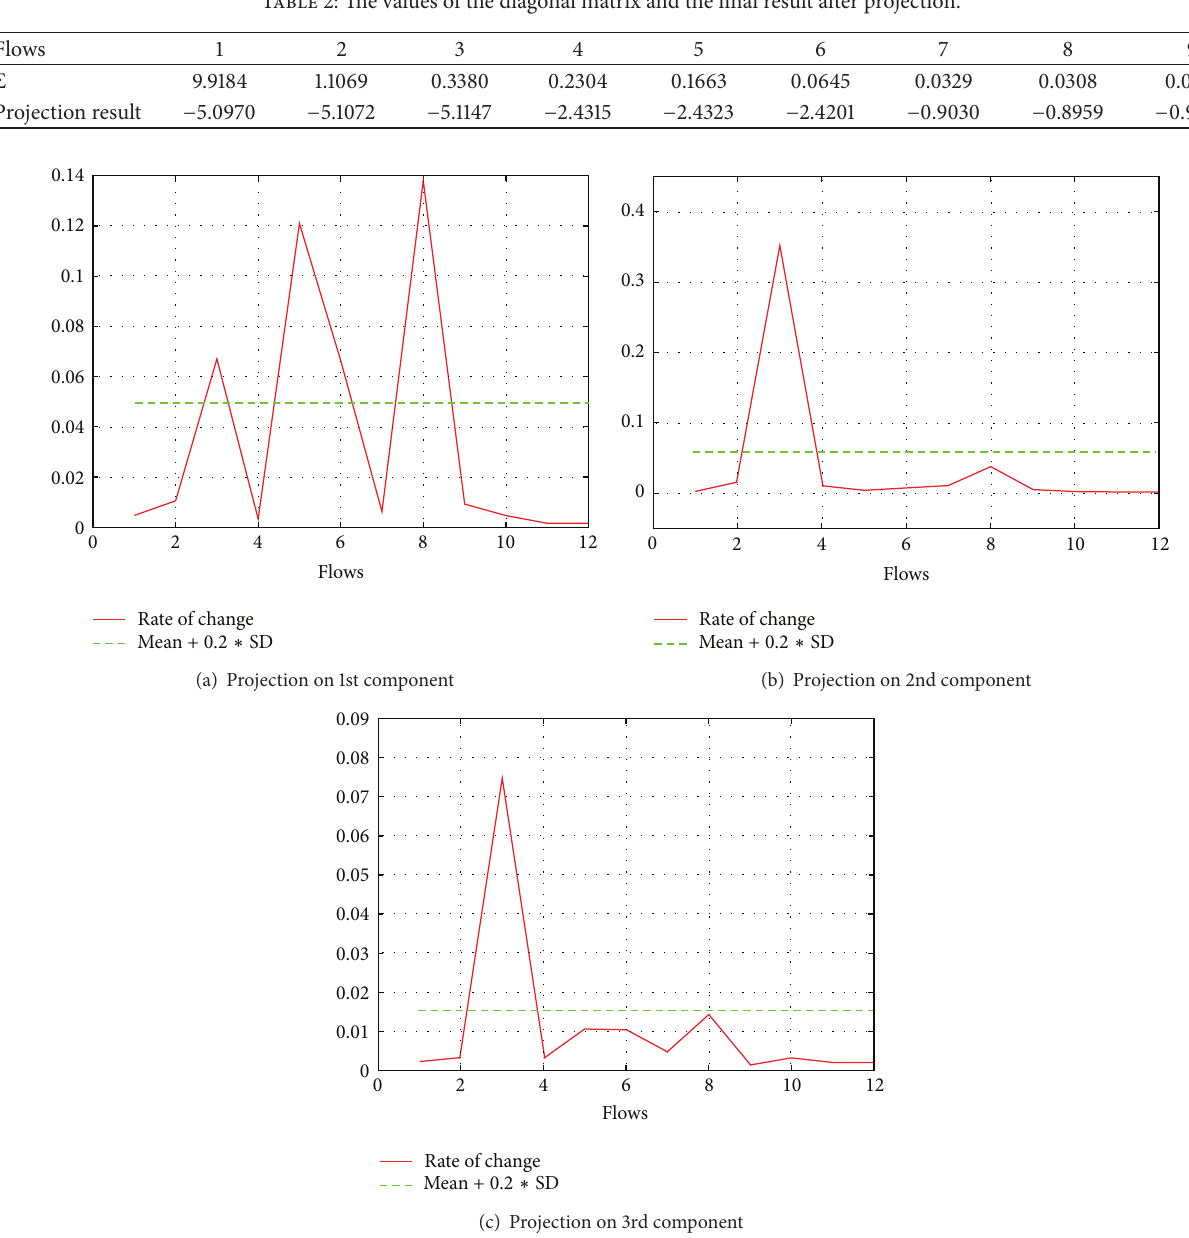
Figure 5: Results of asymmetric topology with RED as drop policy and projecting on different components of diagonal